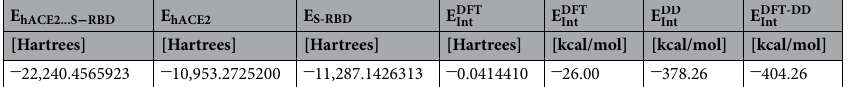
a Table 1. Energies of the human receptor (hACE2), spike protein binding domain (S-RBD) and their DFT E DFT − DD interaction energies without ( E Int ) van der Waals dispersion corrections [DD] Int ) and with ( energies computed with the B3LYP 31 functional and 6-31+G* basis in the gas-phase. (DD) dispersion evaluated with the B3LYP-DD semiempirical method 27